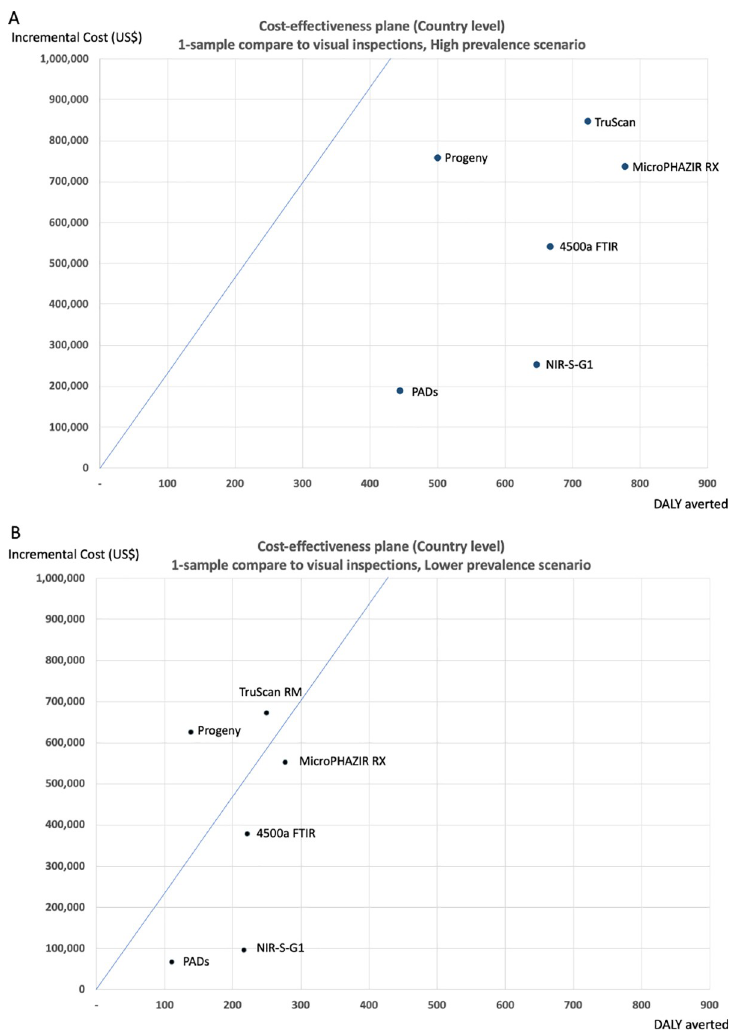
Fig 3. Incremental costs and effects of inspection with a 1-sample strategy in (A) high prevalence scenario; 20% substandard and 20% falsified and in (B) lower prevalence scenario; substandard 10% and falsified 5%, compared with visual inspection. The diagonal line represents the Willingness to pay threshold at US$ 2,353, Lao PDR GDP per capita).